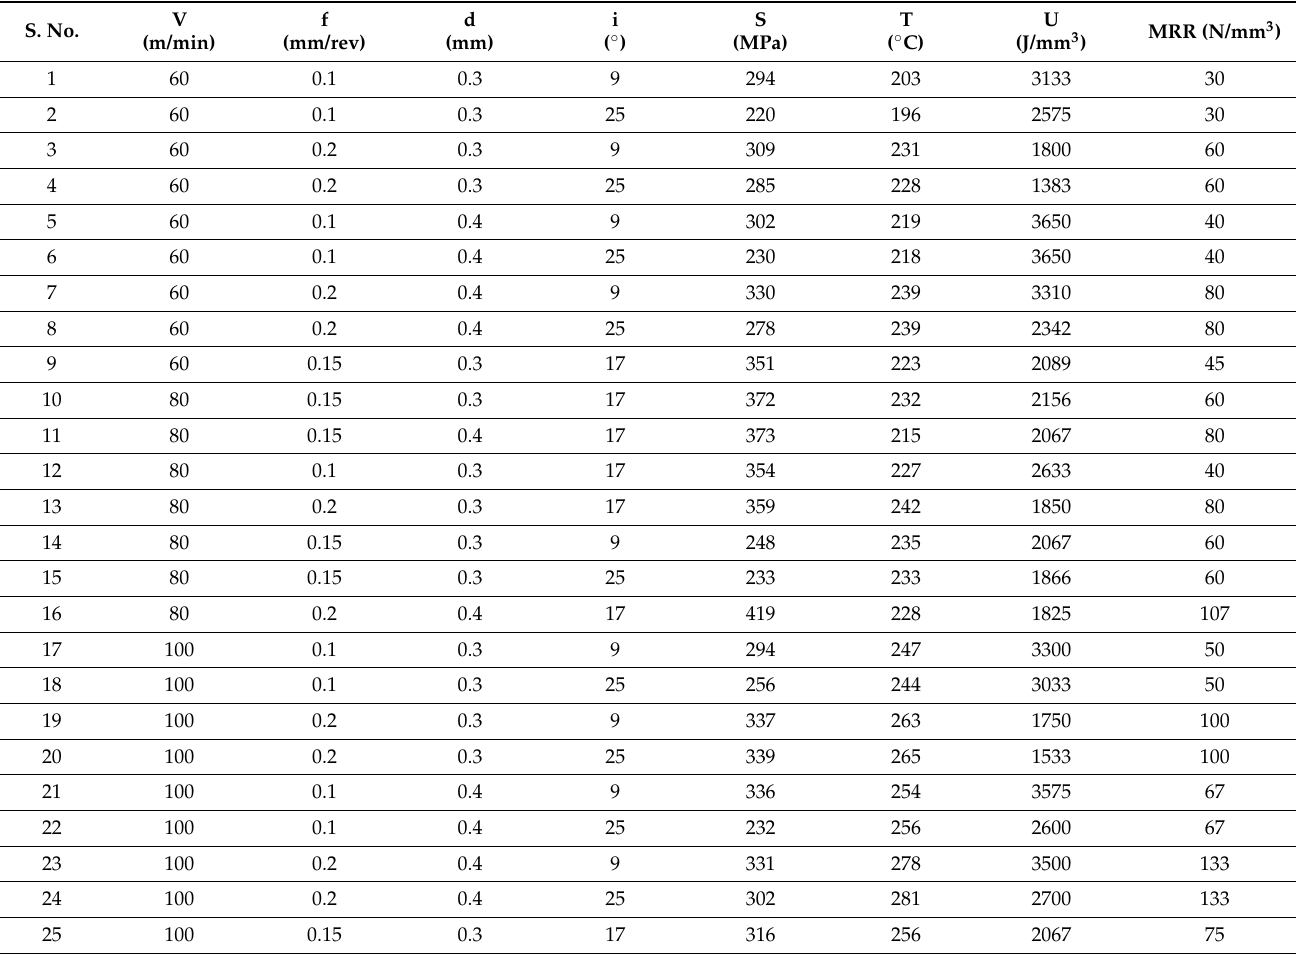
Table 5. CCD-25 matrix with input and output variables from SPRT